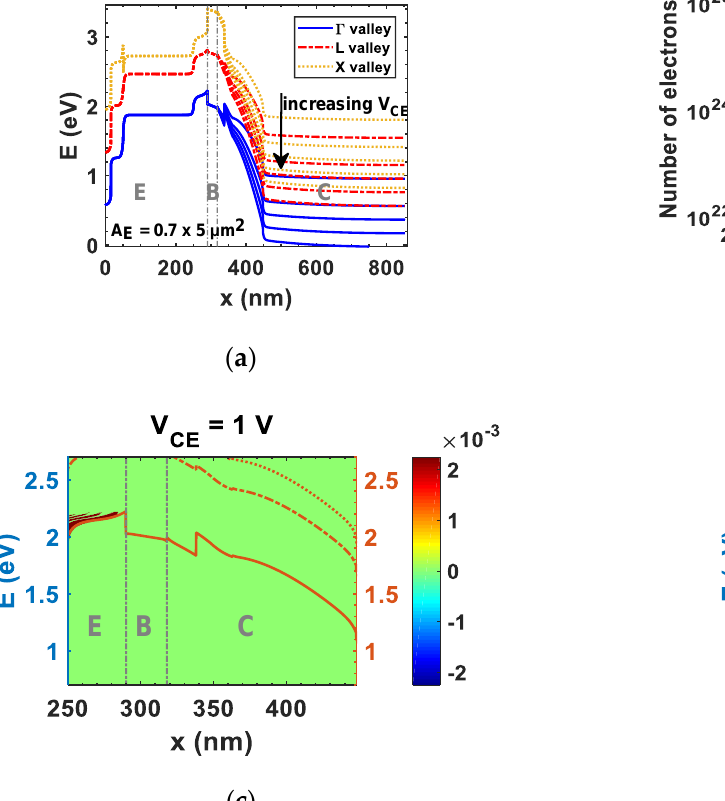
Figure 21. ( a ) Simulated conduction band diagrams of the considered DHBT with increasing V CE (1, 1.4, 1.6, 1.8 and 2 V) at V BE = 0.9 V; ( b ) spatially resolved electron concentration inside the active E–B–C domain at V CE = 1, 1.6, 1.8 and 2 V for V BE = 0.9 V; ( c ) energy and spatially resolved electron concentration n ( x , E ) inside the active E-B-C region at V CE = 1 V, V BE = 0.9 V. The solid line refers to the Γ valley, the dashed dotted one to the L valley, and the dashed one to the X valley; ( d ) same as ( c ), but at V CE = 1.8 V and V BE = 0.9 V. The increased number of electrons in the X valley highlighted by the orange dashed oval indicates a significant transfer of electrons from the Γ to the X valleys at high electric field.